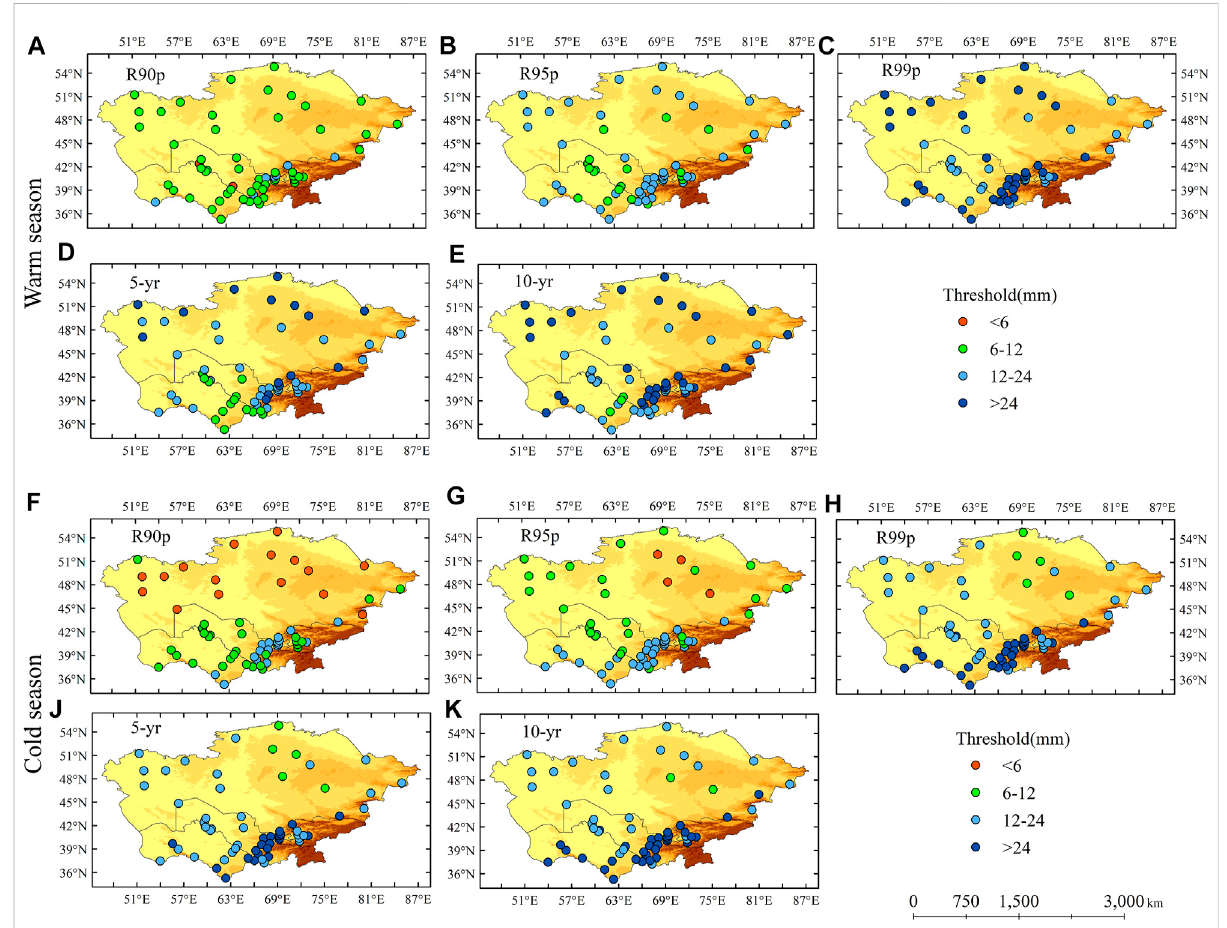
FIGURE 4 Spatial distribution of non-parametric (A – C,F – H) and parametric (D,E,J,K) approaches threshold criteria in warm (A – E) and cold (F – H,J,K) season over Central